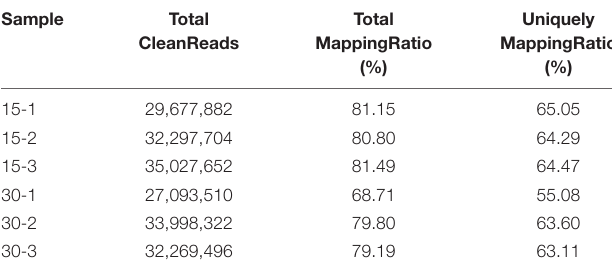
TABLE 5 | Statistics of reads mapped to the genome of six